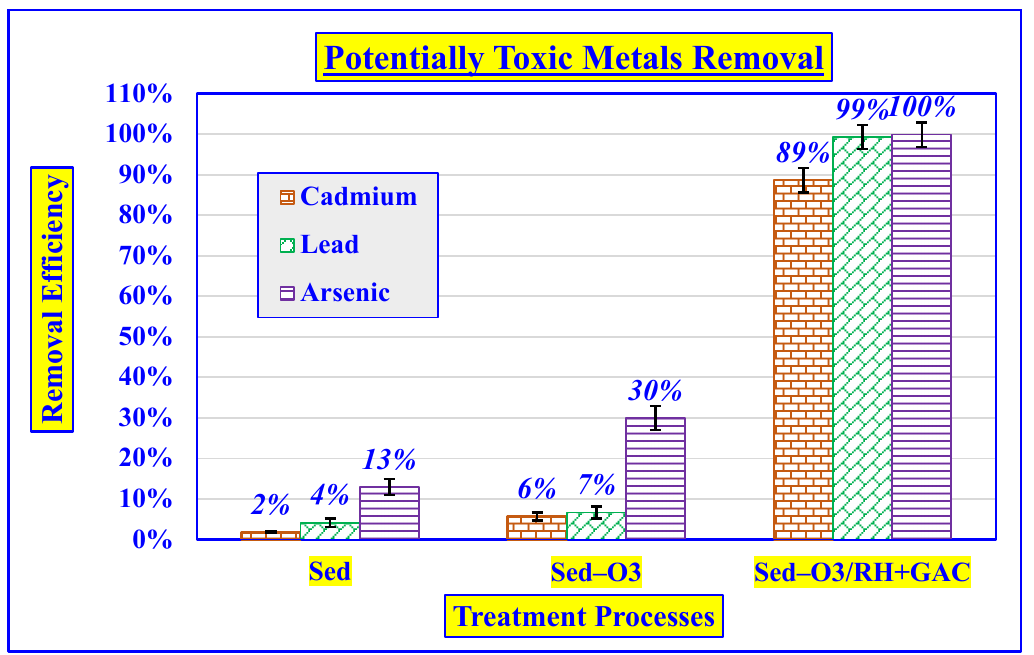
Figure 12. Toxic metals removal by hybrid system (Initial Cd = 0.056 mg/L, Pb = 0.012 mg/L and As = 0.1 mg/L; O3 = 82.5 ± 2.2 mg/L; peristaltic pump speed = 150 rpm; C.T = 18 min; GAC = 200 g; RH = 200 g; pH = 6.9 ± 0.2; volume = 4 L; T = 25 ± 2 C).